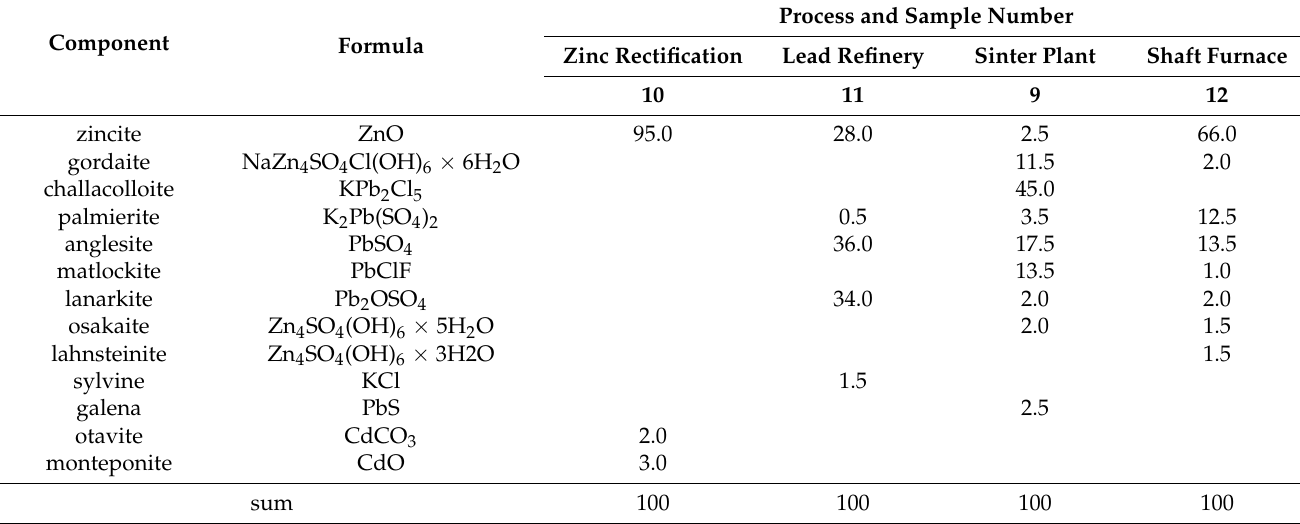
Process and Sample Number Zinc Rectification